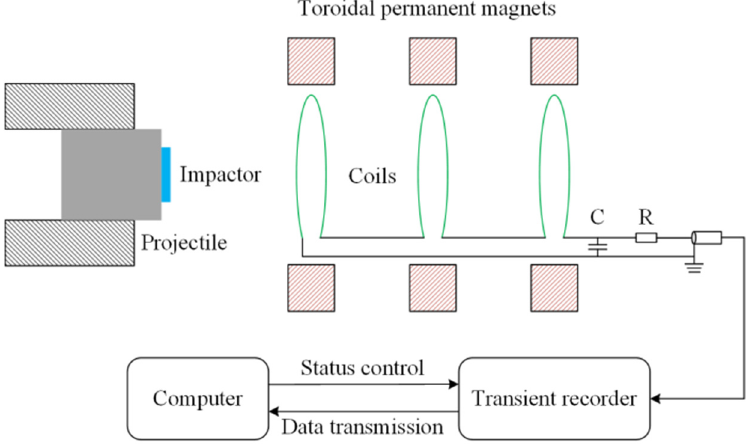
Figure 18. Schematic diagram of MAVIS.